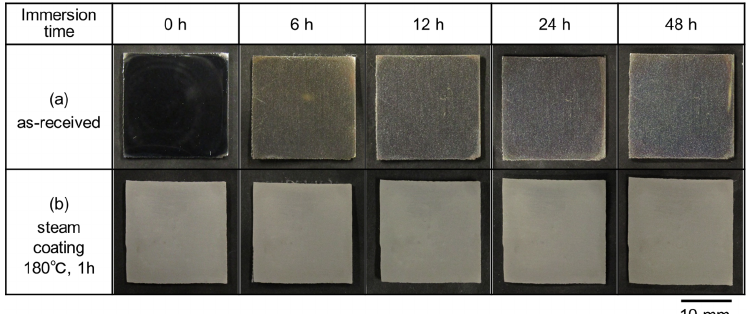
at 180 °C for 1 h, after immersion corrosion test in NaCl solution for up to 48 h.